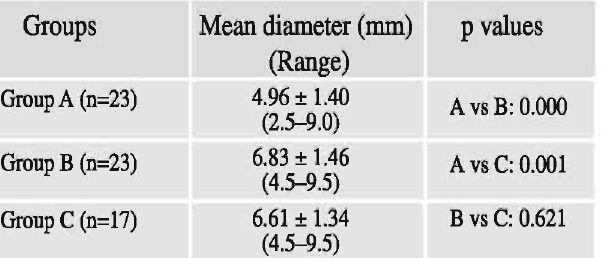
Table IV: Comparison of mean diameters of